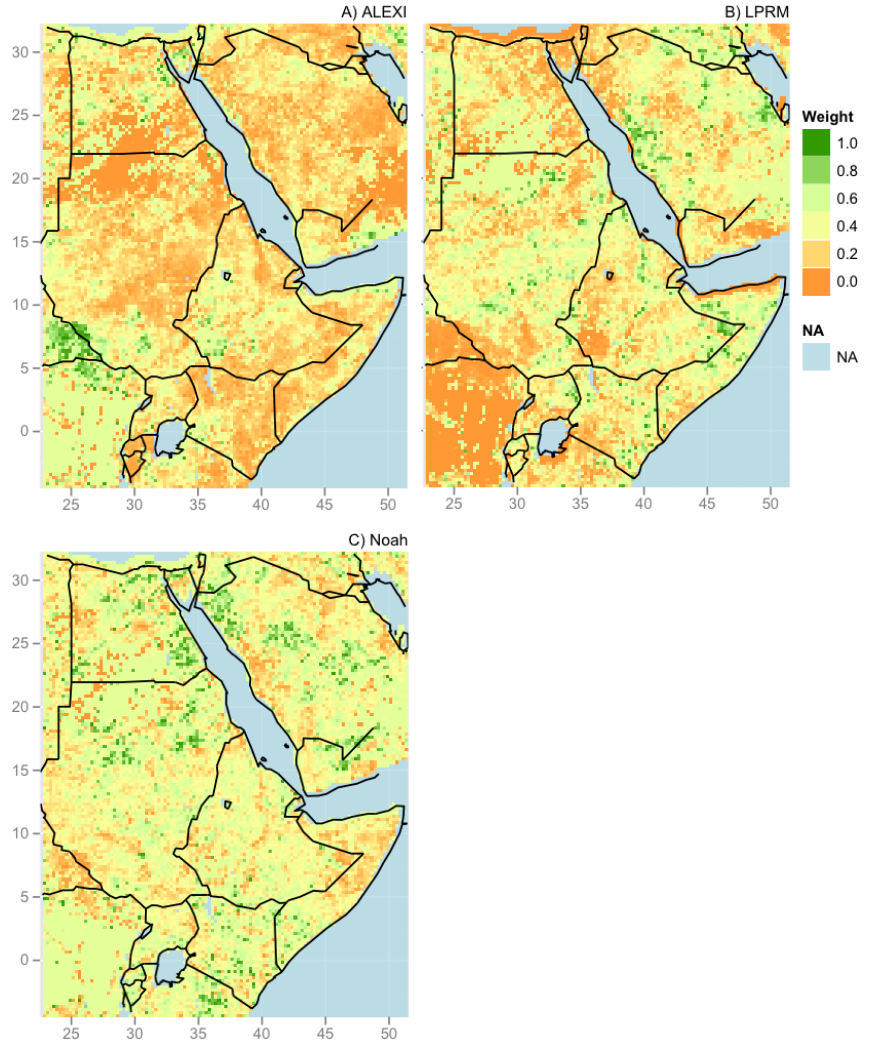
Fig. 9. TCA-based weight map for the case in which data are available from all products for (A) ALEXI, (B) LPRM and (C) Noah. The sum of weights per location adds to